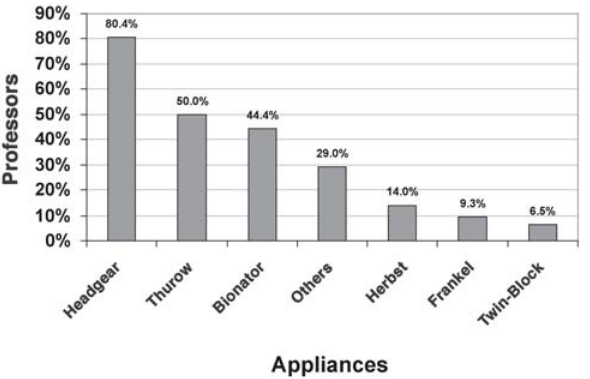
FIGURE 1- Frequency of use of different types of orthodontic appliances adopted by professors for the Class II malocclusion early treatment